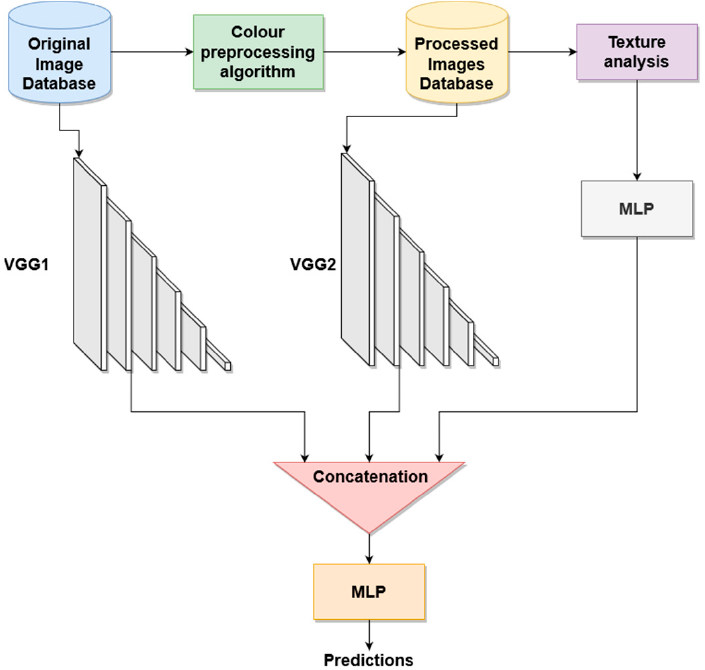
Figure 6. Triple classification. Original RGB , color-quantized images and texture descriptors are used as inputs to the MLP classifier.